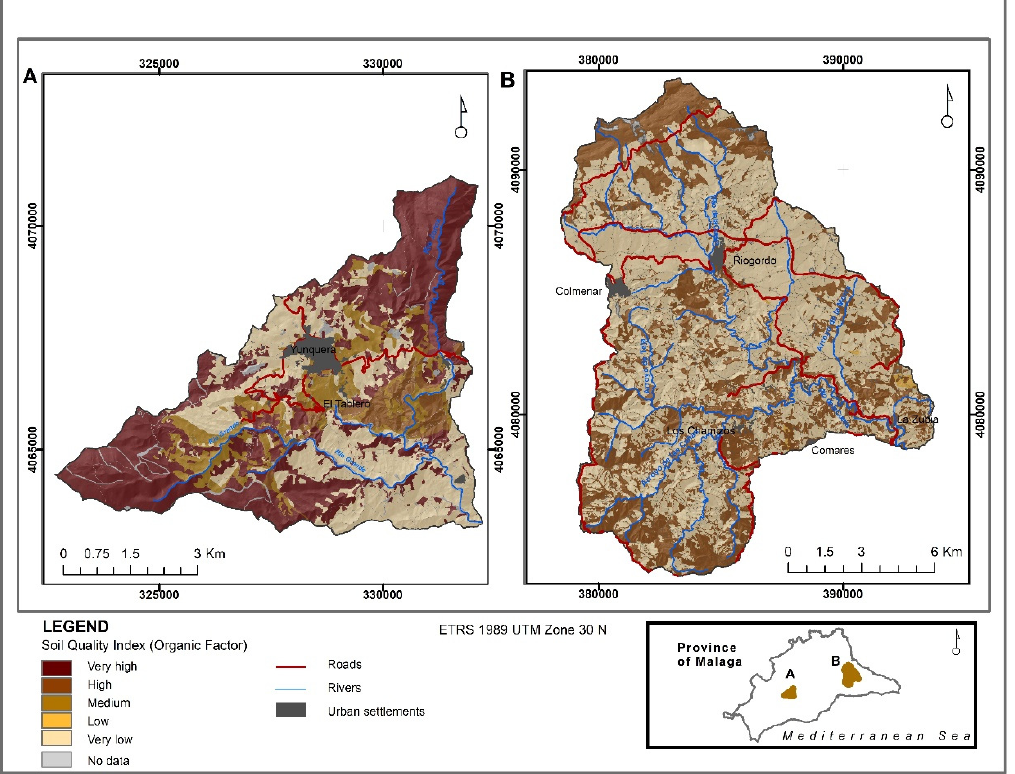
Figure 4. Organic factor in the soil quality index. Maps display the spatial distribution of each category of soil quality according to organic indicators in ( A ) GR and ( B ) BE.